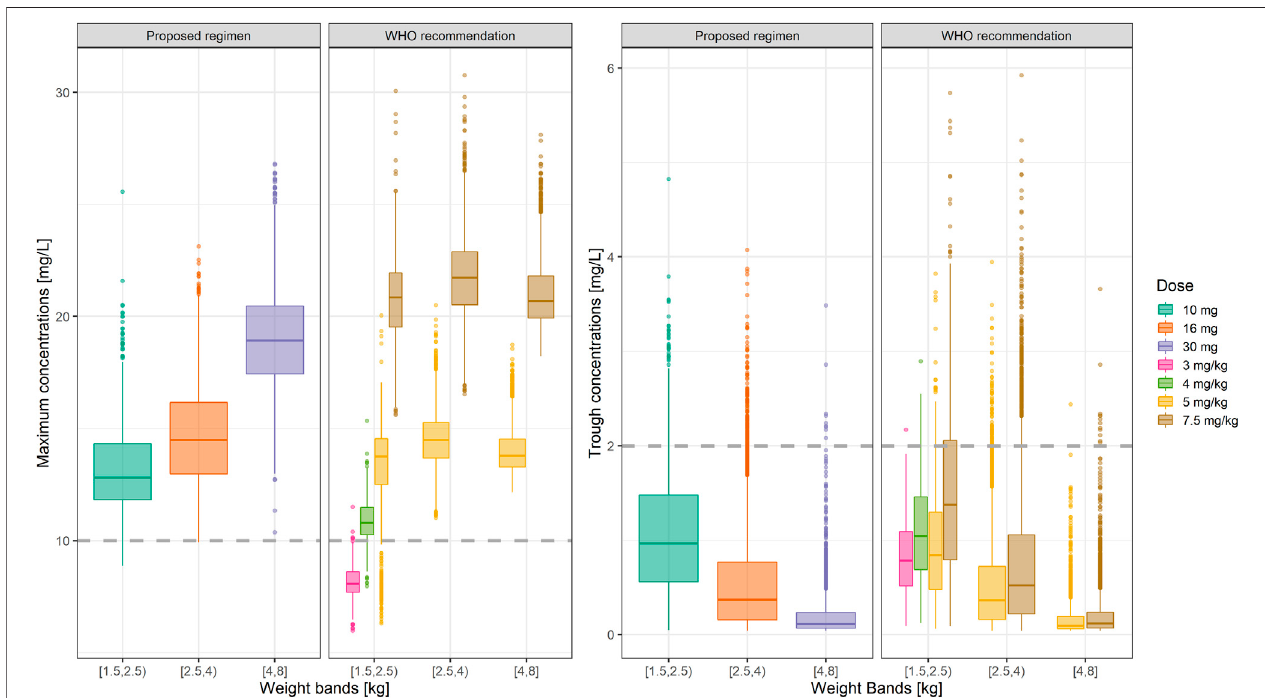
FIGURE 6 | Predicted gentamicin peak (left) and trough (right) concentrations in sepsis patients aged between 0 and 59 days strati fi ed according to the weight bands for the proposed simpli fi ed regimen. Panels show how the simpli fi ed regimen compares to the 2015 WHO recommendations. Hinges represent 25 th and 75 th percentiles (respectively, Q1 and Q3), whiskers represent Q1 − 1.5IQR and Q3 + 1.5IQR, respectively, where IQR is the interquartile range. All the subjects outside this range are represented by the dots ( N (cid:1) 9,994). Dashed lines represent the threshold values for peak and trough concentrations of 10 and 2 mg/L, respectively.